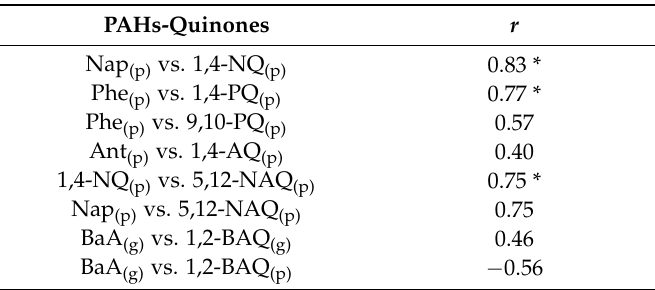
Table 9. Spearman coefficients for quinones and PAH